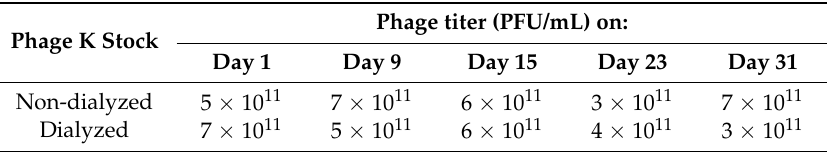
Table 2. Stability of phage K suspended in